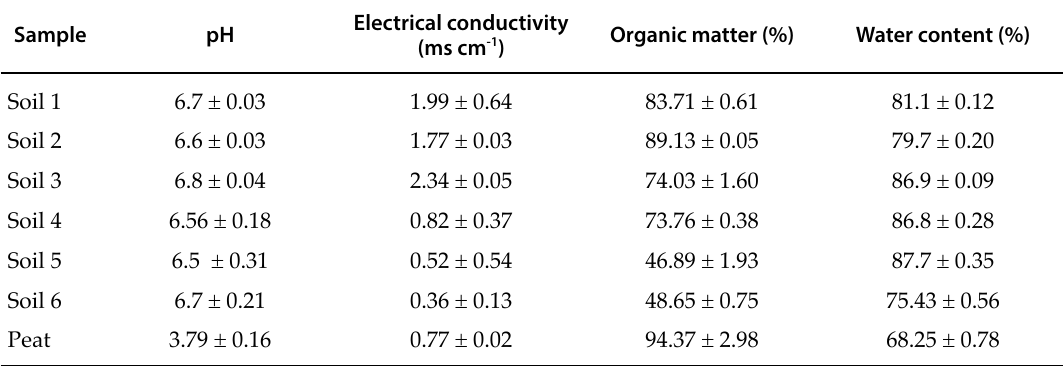
Table 1. Physicochemical parameters of soils and peat used in this work.